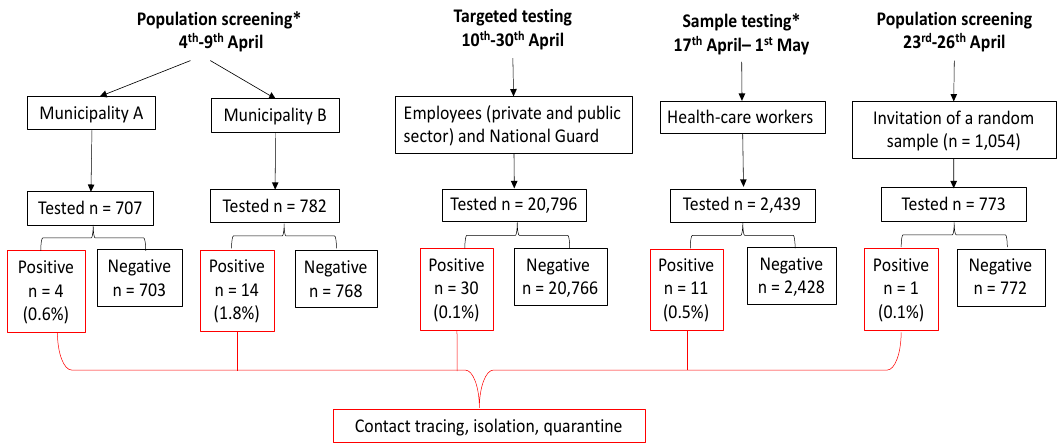
Figure 2. Outline of testing activities, Republic of Cyprus 9 March–3 May 2020. * aggregate data reported to the Ministry of Health.